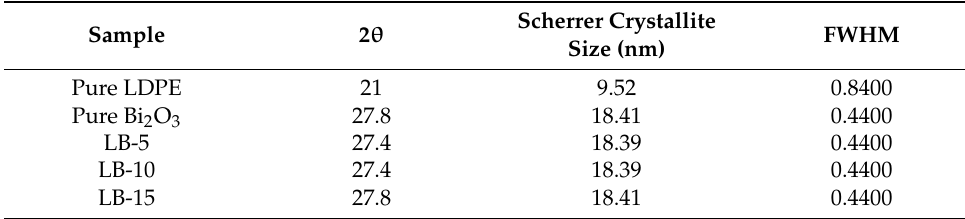
Table 5. Crystallite size of the LDPE composites.